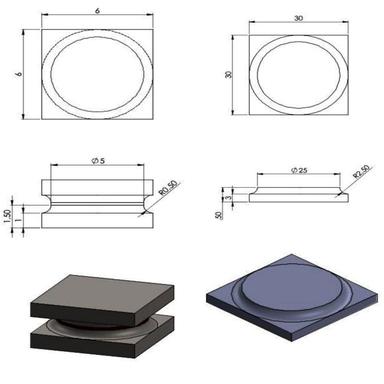
Size of hourglass shaped samples; both of them are made of steel (Crofer 22 APU), machined in the hourglass shape, cut in two parts, then joined by applying the sealant slurry between the two parts: TGH-5 samples (a) have a joined area diameter of 5 mm, a total height of 3 mm; THG-25 samples (b) have been designed by multiplying the previous diameter and curvature radius by five. (half hourglass is shown in).